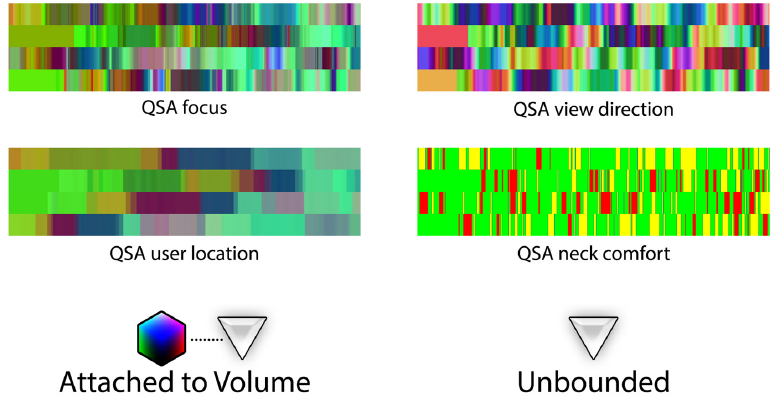
Figure 6. Examples of QSAs generated by prisms attached to a volume to track spatial attributes over time ( left ) and standalone ( right